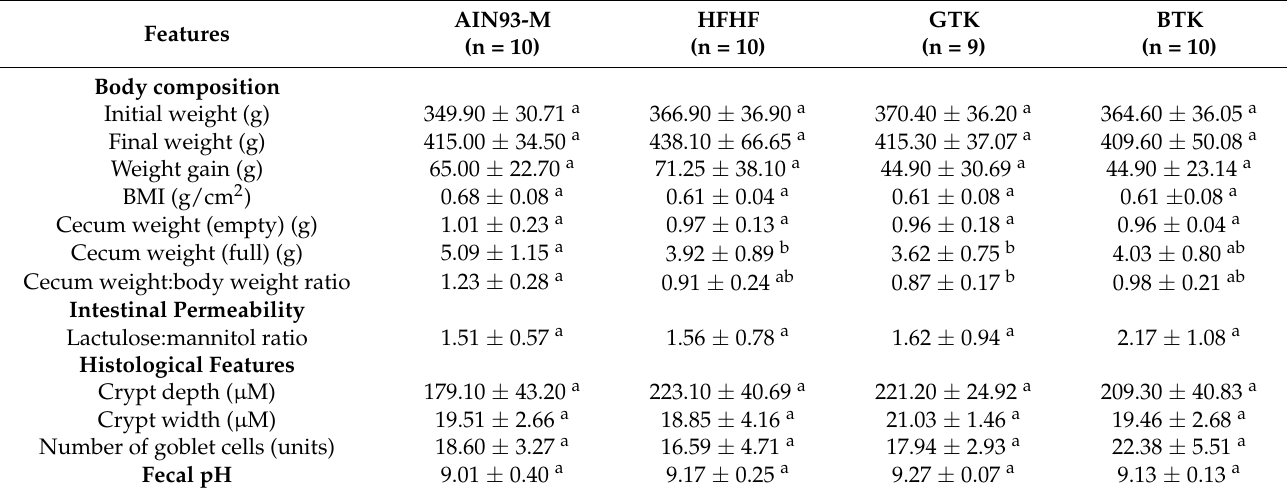
Table 2. Body composition and intestinal parameters of the animals after 10 weeks of